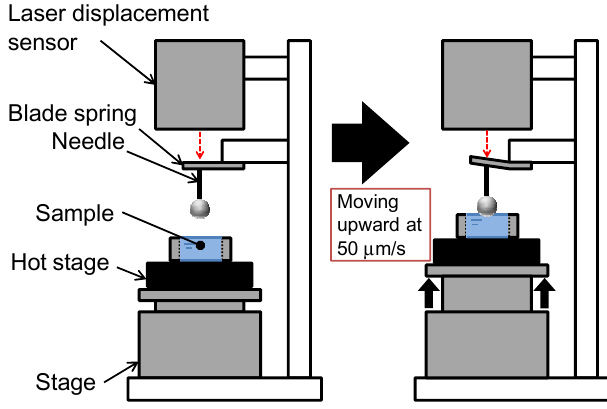
Figure 6. Schematic diagram of stiffness measurement apparatus.